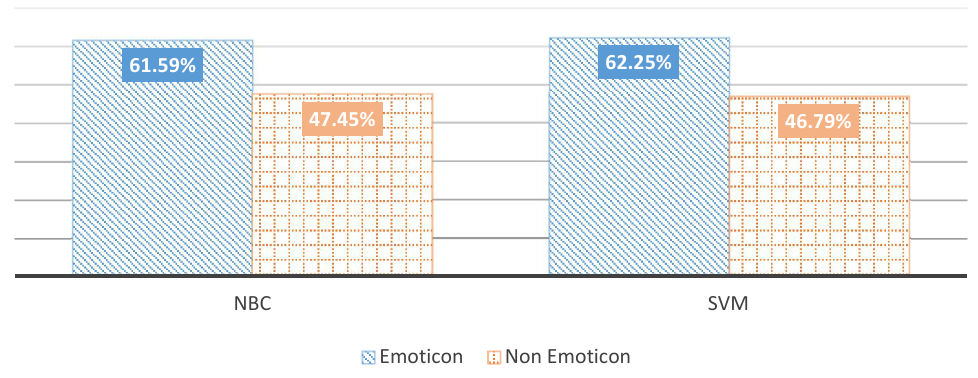
Fig. 5. Graph of comparison of quality measures in sentiment analysis with detection of